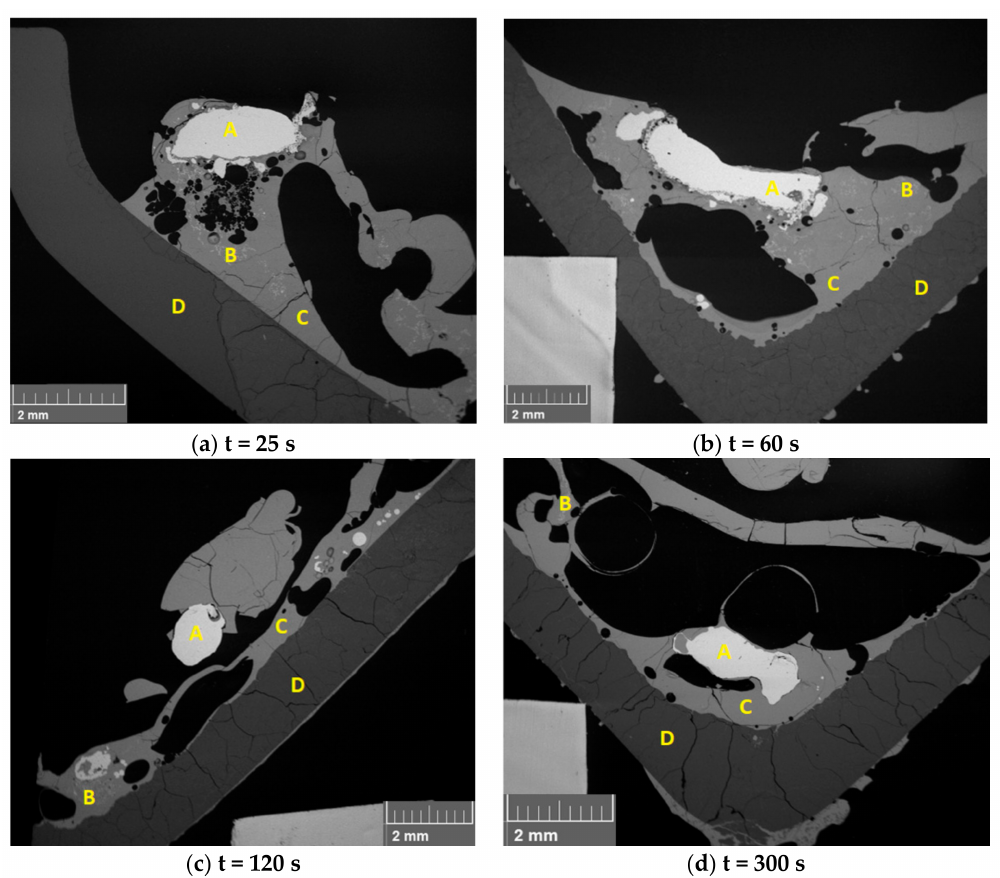
Figure 5. SEM-BSE micrographs of the synthetic PCB specimens after different melting times. The letters indicate ( a ) alloy droplets from PCB, ( b ) unreacted iron from the slag mixture, ( c ) liquid slag, and ( d ) silica